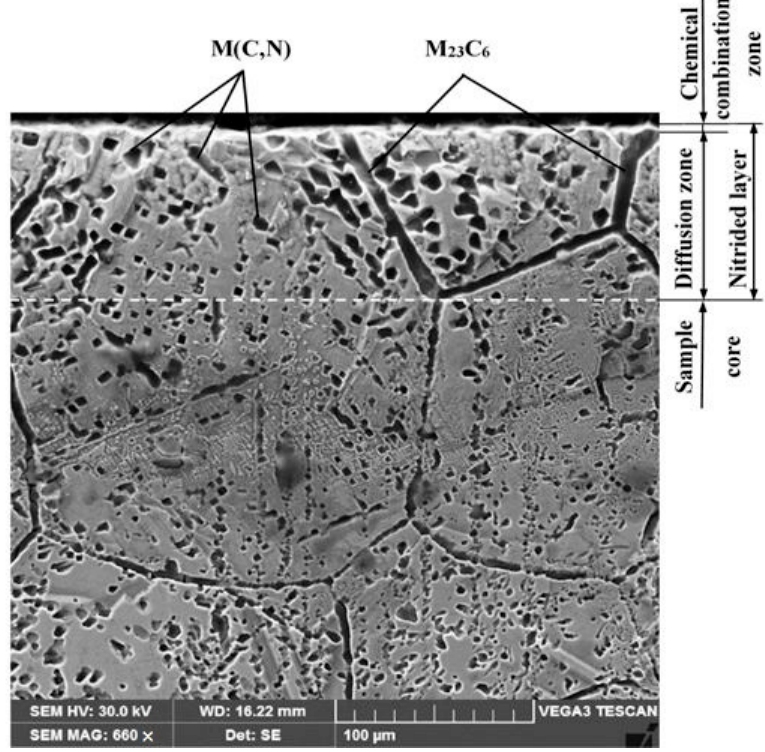
Figure 9. SEM image of the cross-section microstructure of the nitrided layer.